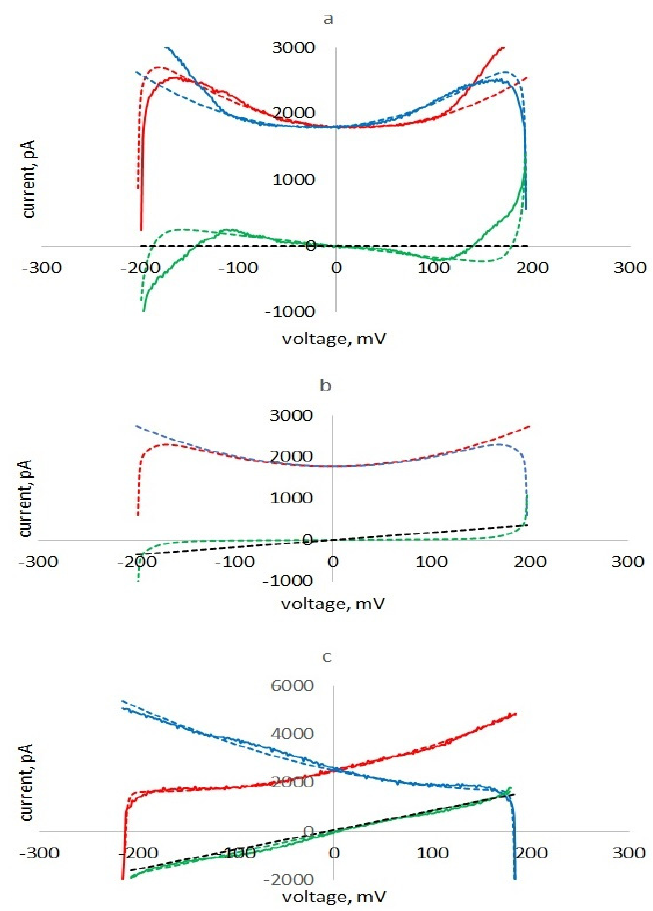
Figure 8. Experimental (solid) and calculated (dotted lines) hysteresis curves I 0,up (red), I 0, down, inv (blue) and their halfsum (green) and calculated ionic currents (dotted black lines) for three cases: with negative ( a ), zero ( b ) and positive ( c ) apparent conductance. Experimental curves—current responses of the azolectin membrane in 0.1 M KCl with low ( a ) and high ( c ) conductance to a triangular voltage with a frequency of 2 Hz and an amplitude of 200 mV. Equivalent circuit parameters: C 0 = 1120 pF ; τ = 10 ms ; β = 15 V − 2 ; f = 2 Hz ; U max = 200 mV ; γ = 0; g = 0 ( a ), 1.72 nS ( b ), 8 nS ( c ).